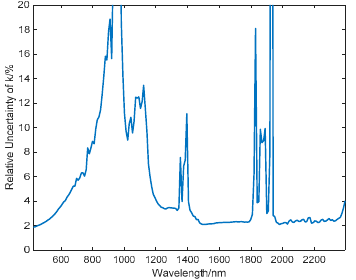
Figure 8. The coefficient fitting of ( a ) band112 and ( b ) band 156. Significance level is 0.10.